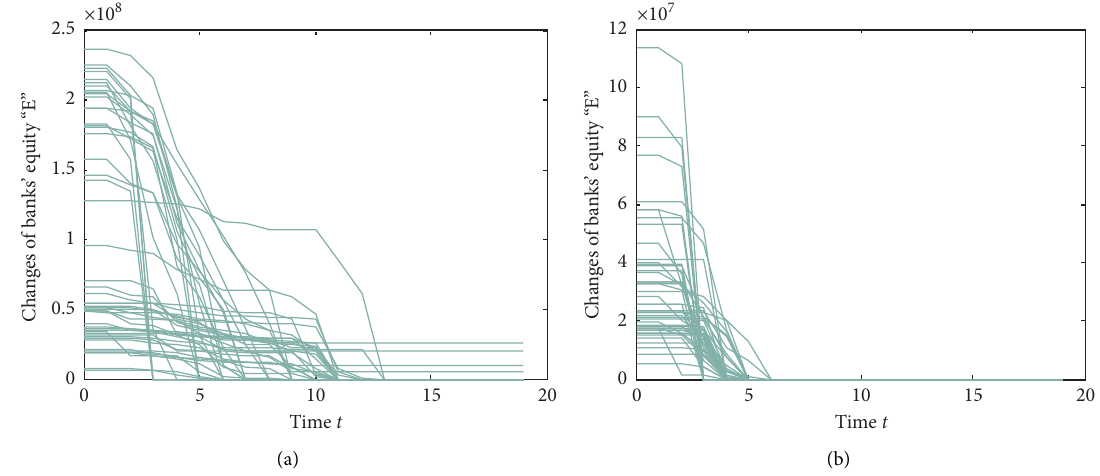
Figure 3: Losses of banks’ equity over time influenced by different network